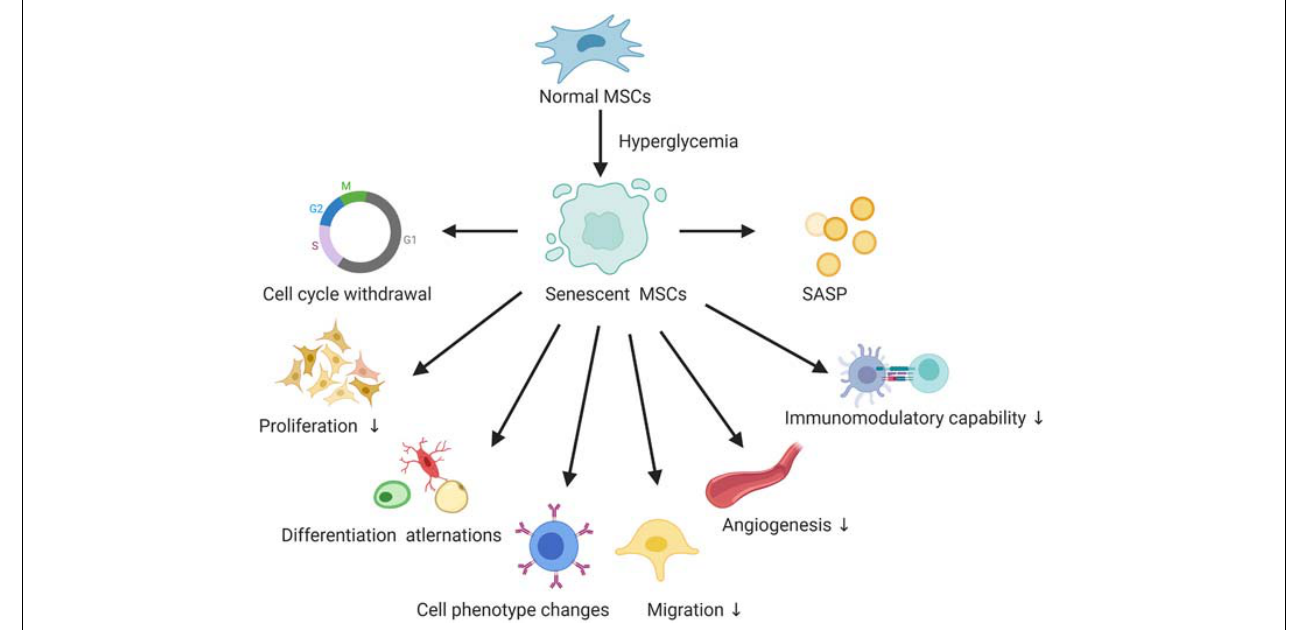
FIGURE 1 | The hallmarks of senescent MSCs in the hyperglycemic microenvironment. SASP, senescence-associated secretory